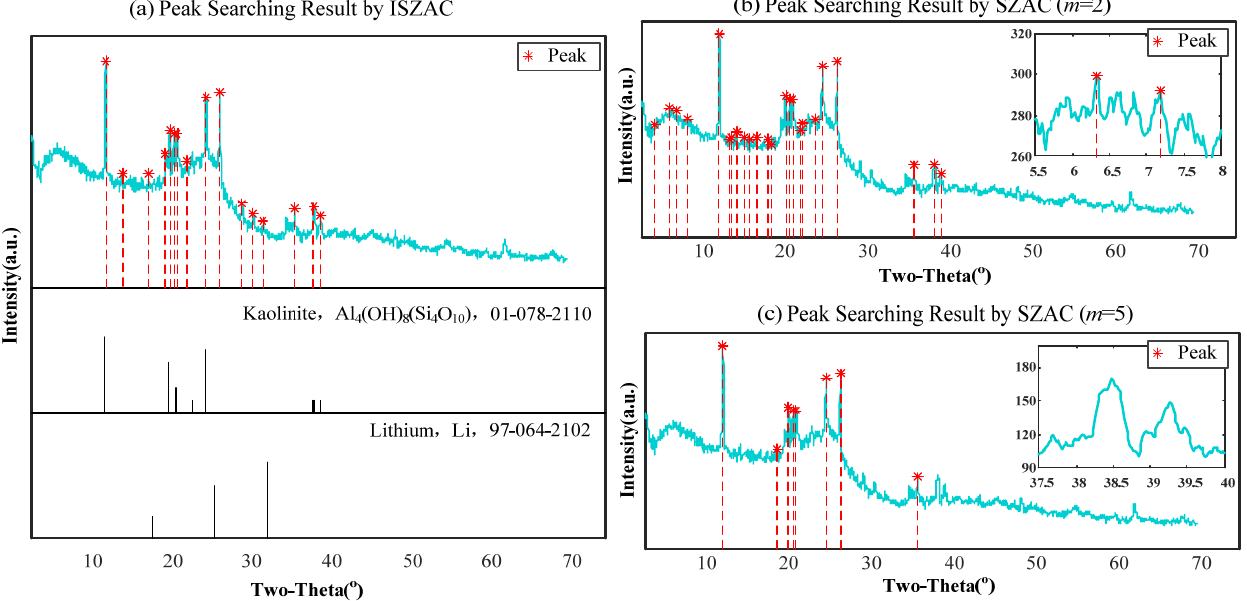
Figure 5. Peak search results of XRD pattern of lithium in coal.